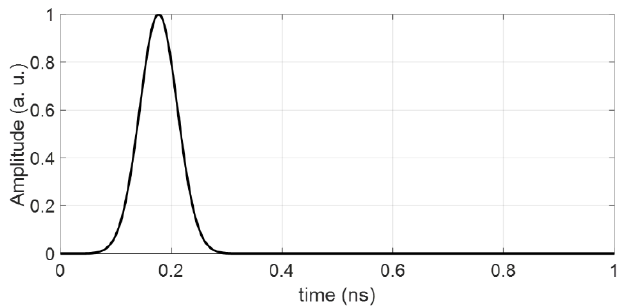
Figure 2. Gaussian pulse with a bandwidth of 0 to 10 GHz that was used.